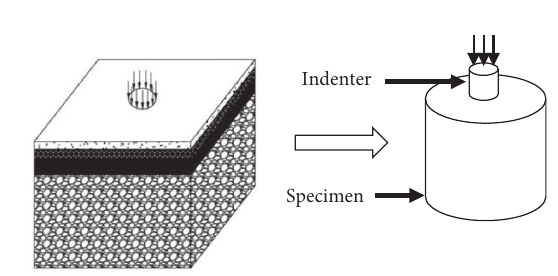
Figure 1: Test principle of UPT.